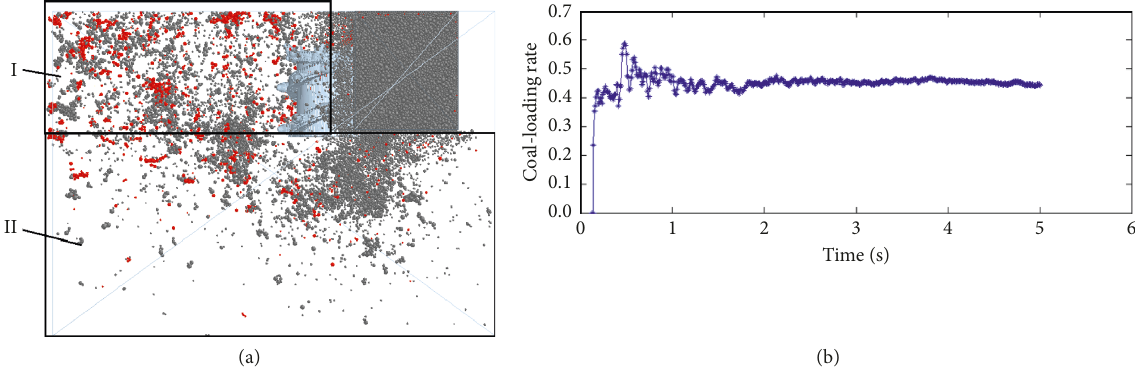
F IGURE 5: The total force of the teeth. The force of the (a) 11th and 12th teeth; (b) 13th and 14th teeth; (c) 15th and 16th teeth; (d) 17th and 18th teeth; (e) 19th and 20th teeth; (f) 21st and 22nd teeth; (g) 23rd and 24th teeth; (h) 10th tooth; (i) 9th tooth; (j) 7th and 8th teeth; (k) 5th and 6th teeth; (l) 1st, 2nd, 3rd, and 4th